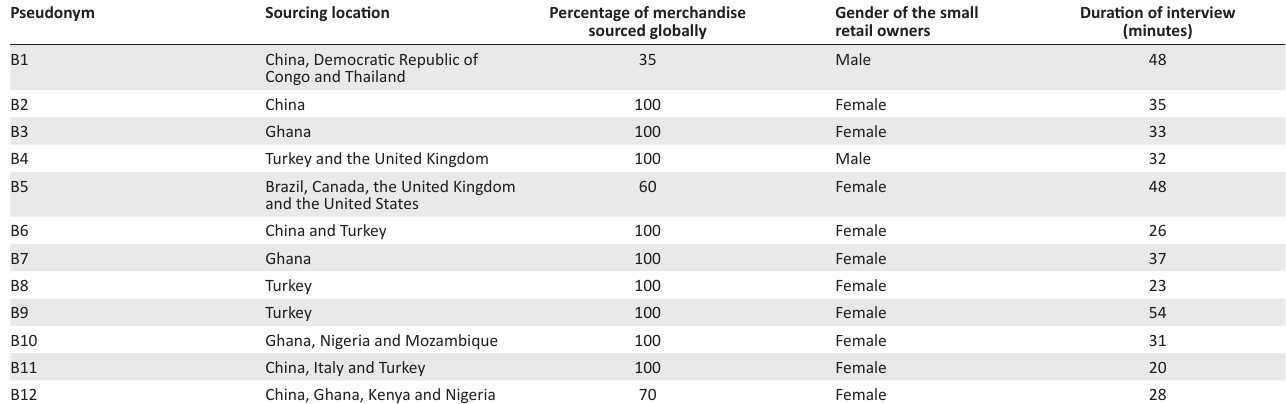
TABLE 3: Details of the small retail owners who participated in the